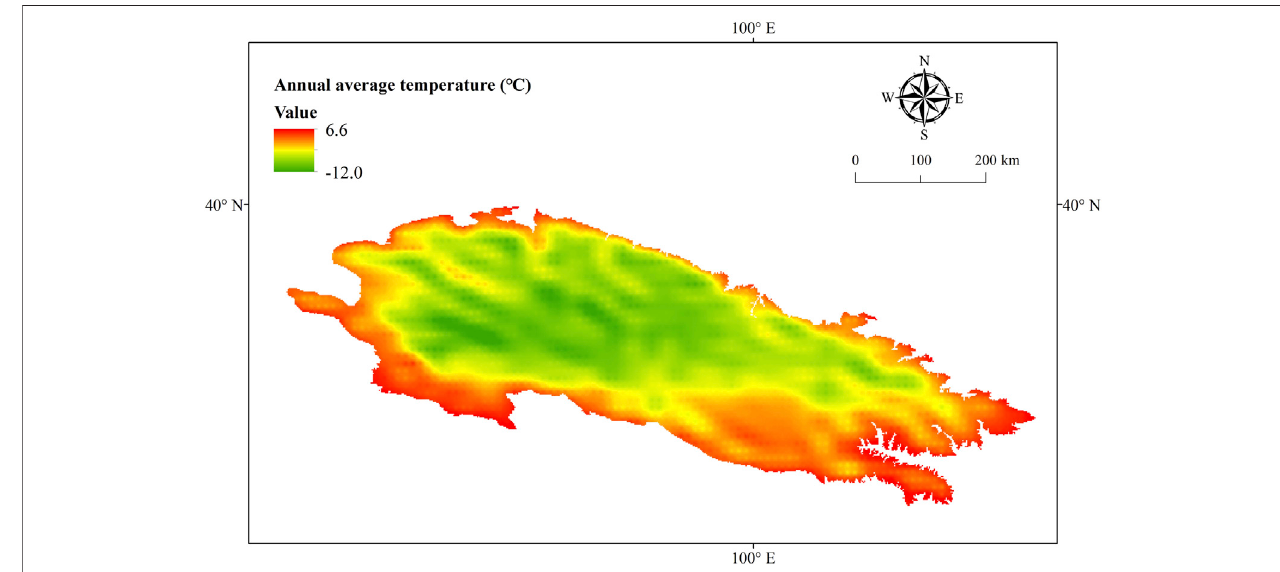
FIGURE 2 | Spatial distribution of annual mean ERA5-Land temperature in the QLM.